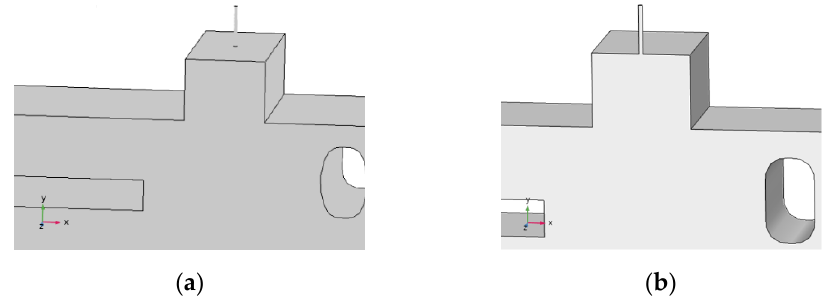
Figure 2. Magnification of the section at the left fuel inlet pipe zone. ( a ) Geometry 1: fuel inlet pipes in the z -axis, and ( b ) Geometry 2: fuel inlet pipes in the z -axis.